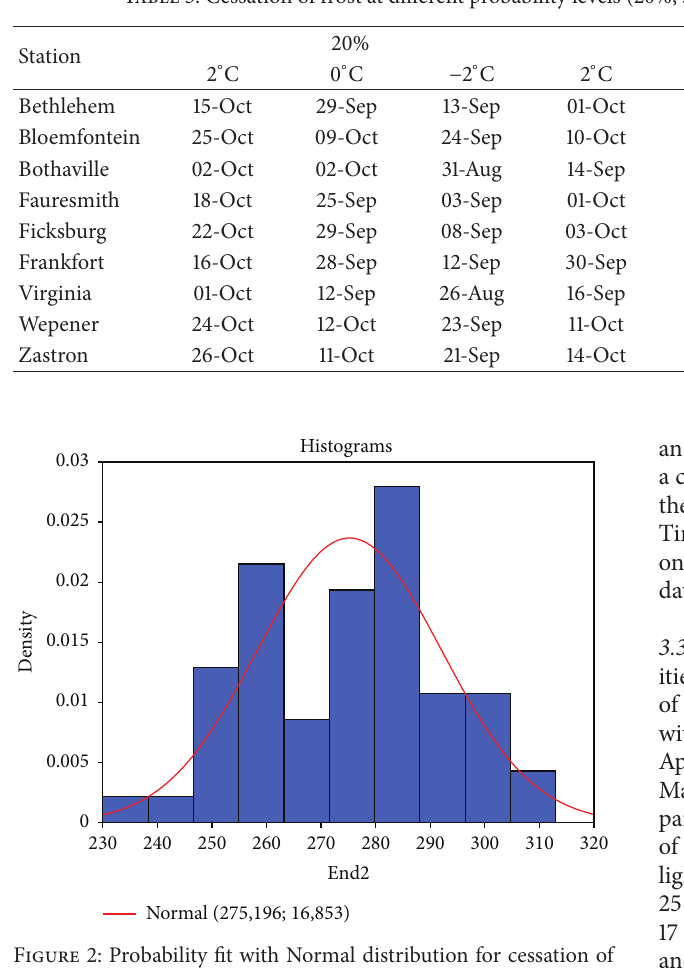
Table 3: Cessation of frost at different probability levels (20%, 50%, and 80%) and thresholds (2 ∘ C, 0 ∘ C, and − 2 ∘ C).